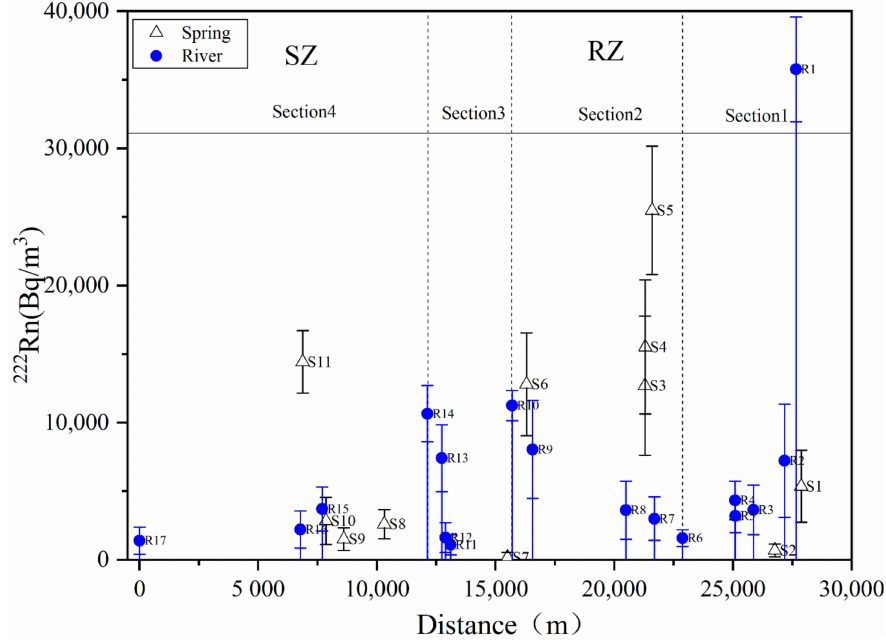
Figure 9. 222 Rn concentration changes of river water and springs along the RZ and SZ rivers. The error bars represent the standard deviation of all 222 Rn